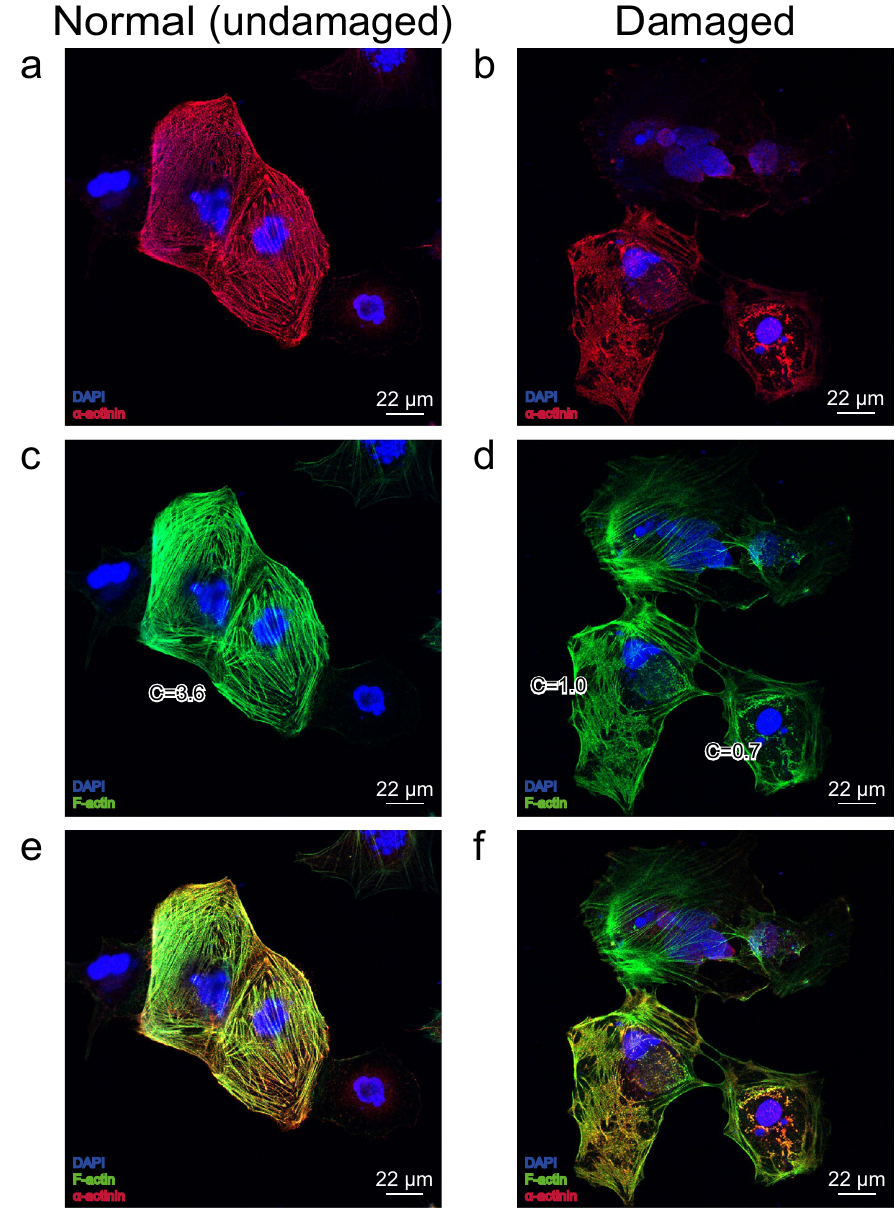
Figure 6. Confocal imaging of F-actin, α-actinin and DAPI in hiPSC-CMs. ( a , c , e ) Normal, undamaged cardiomyocytes. C = 3.6 for the presented cells. ( b , d , f ) Bottom part of figure: cardiomyocytes with damaged cytoskeleton after incubation with 213 µM (~ 4 mg/kg) of CP. C = 1.0 and C = 0.7 for cardiomyocytes presented on the